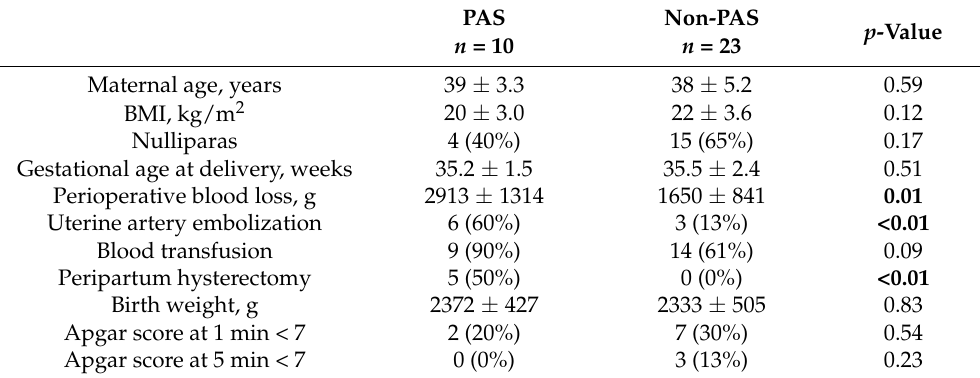
Table 2. Maternal characteristics and perinatal outcomes.